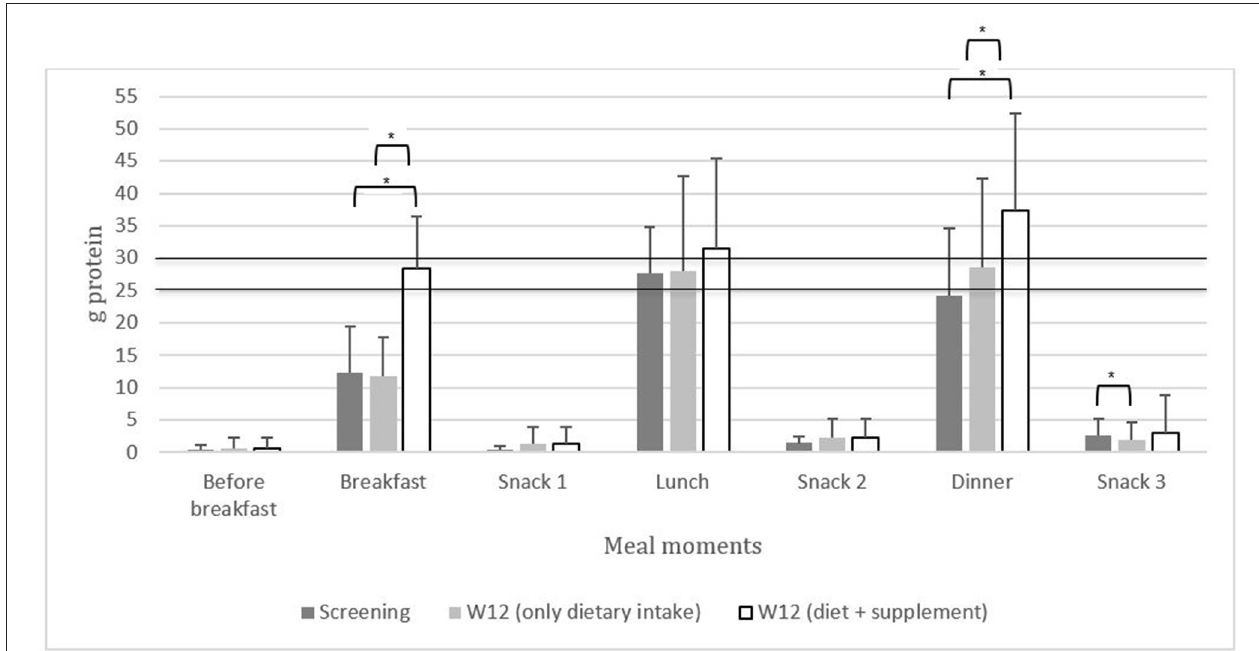
FIGURE 2 | The distribution of protein intake [g (mean ± SD)] across breakfast, lunch, dinner, and snack times in community-dwelling (pre)sarcopenic older adults. The line of 25 and 30g represents the amount of protein required per meal to maximally stimulate muscle protein synthesis according to the PROT-AGE Study Group (16). * p <